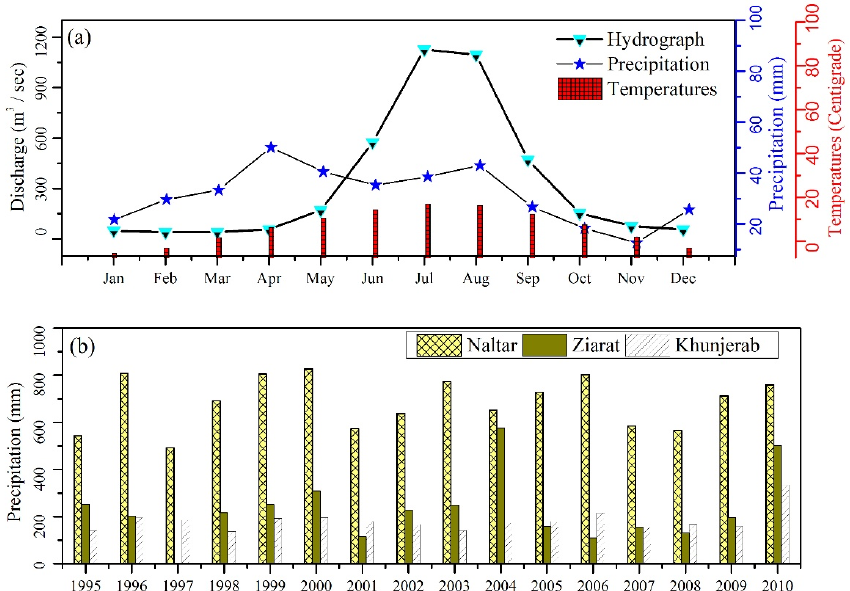
Figure 3. ( a ) Monthly average discharge (m 3 /s), total precipitation (mm), and average temperature (°C) data for Hunza River Basin during the 1966–2010 period. ( b ) Total annual precipitation rec- orded at the three meteorological stations (Naltar, Ziarat, and Khunjerab) in Hunza Basin during the 1995–2010